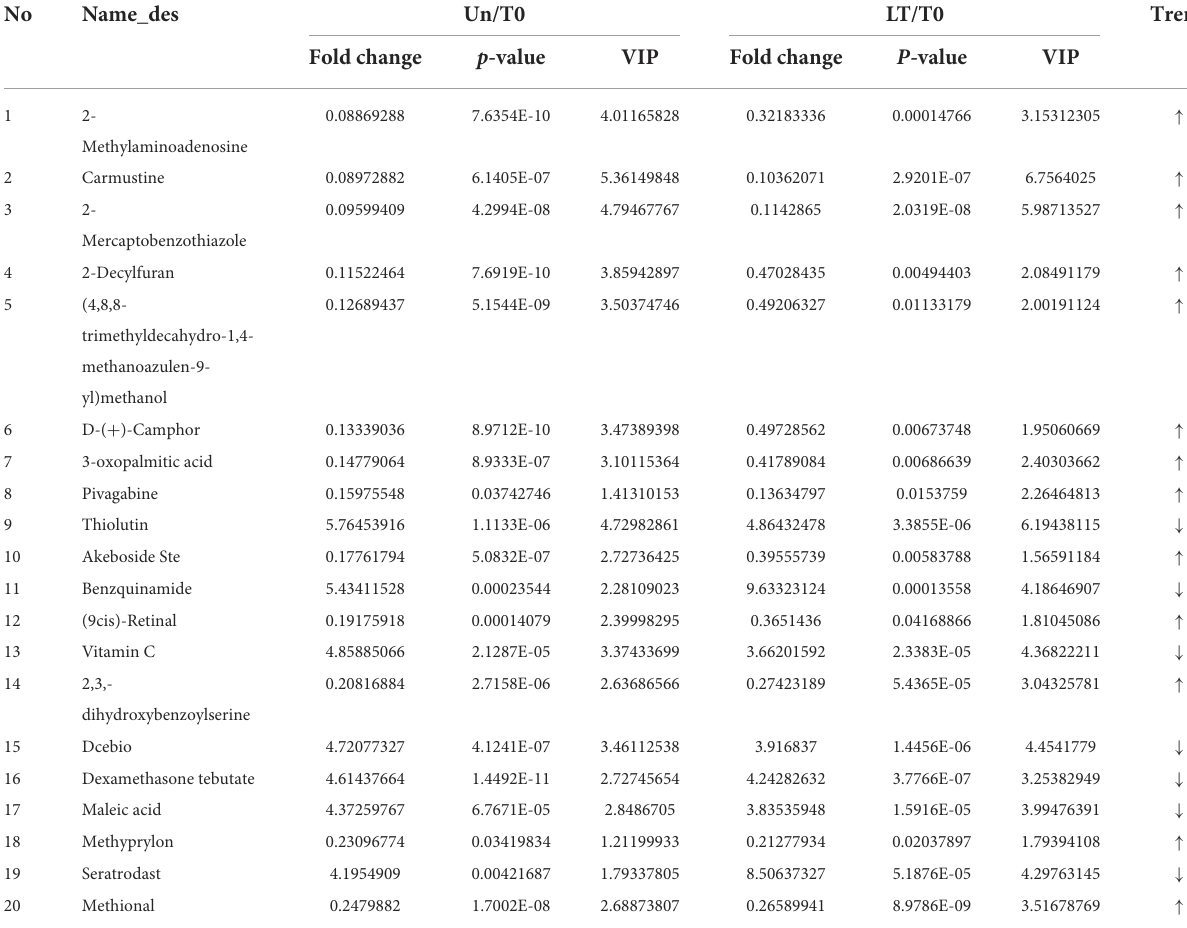
TABLE 2 Top 20 differential serum metabolites of T0 patients identified by LC-MS/MS and GC-MS, compared to LT and Un